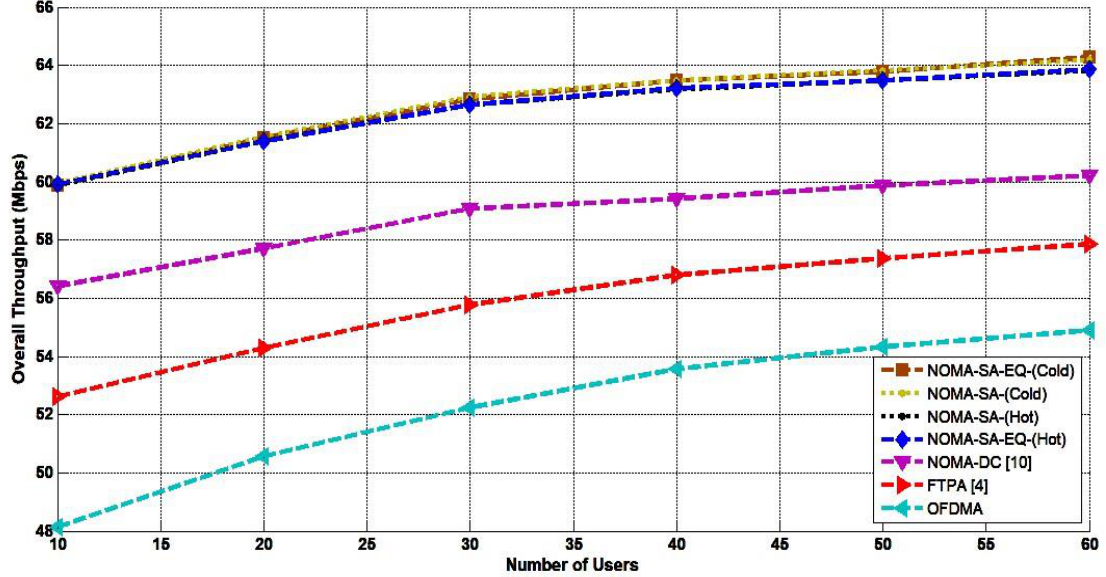
Figure 4. Throughput Versus Number of Users (10–60) with Maximum Transmission Power of 12 Watts.